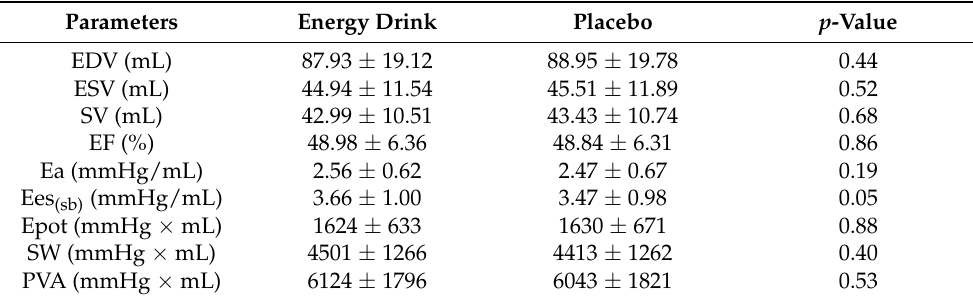
Table 3. Acute Effects of Energy Drinks on Left Ventricular Hemodynamics ( n = 24). Parameters Energy Drink Placebo p -Value EDV (mL) 87.93 ±